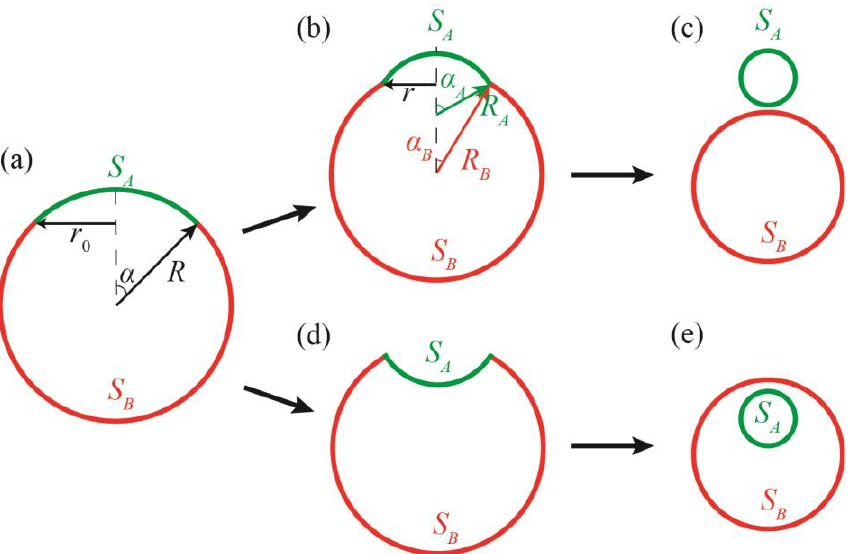
Figure 1. Possible states of a phase-separated vesicle. ( a ) — Initial state of the vesicle immediately after the phase separation. ( b ) — Intermediate state of dividing vesicle consisting of two convex domains. ( c ) — The phase-separated vesicle divided into two separate vesicles. ( d ) — Intermediate state of dividing vesicle, consisting of one convex and one concave domain. ( e ) — The phase-separated vesicle divided into two vesicles forming the DMV. In panels ( b ) and ( d ), the length of the interphase boundary, 2 π r , is smaller than the boundary length in the initial state, 2 π r 0 (panel ( a )) due to buckling of the domain.